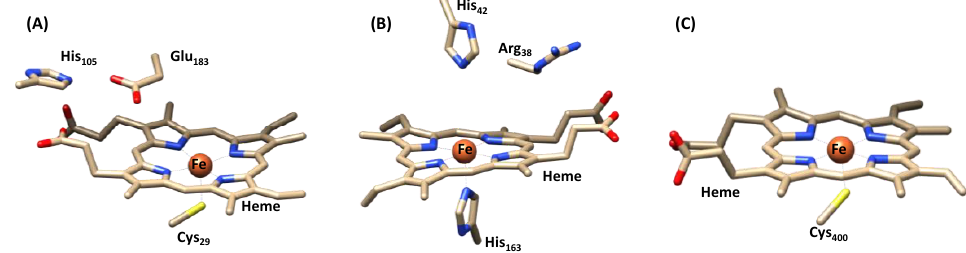
Figure 3. Comparison of the active sites in ( A ) chloroperoxidase (PDB 1CPO [16]), ( B ) peroxidase (PDB 2GHC [17]) and ( C ) cytochrome P450 (PDB 1FAG [18]) enzymes.